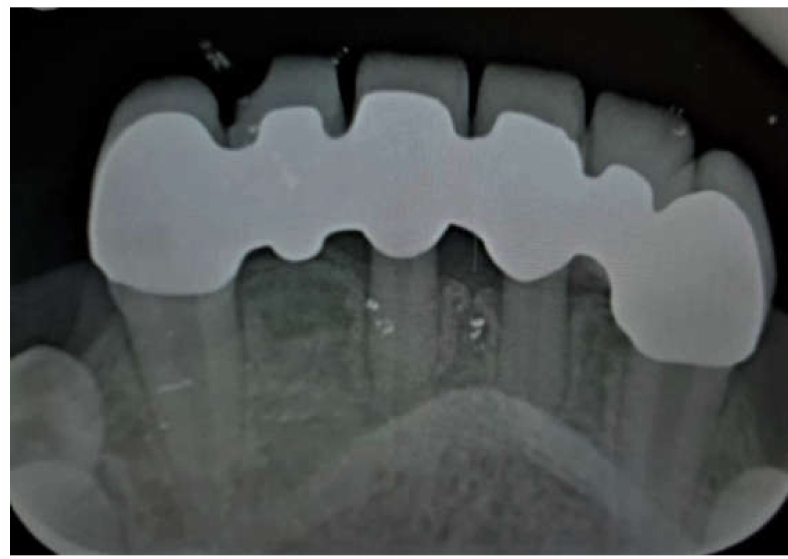
Figure 5. Periapical X-ray. Post-operative, 36 months’